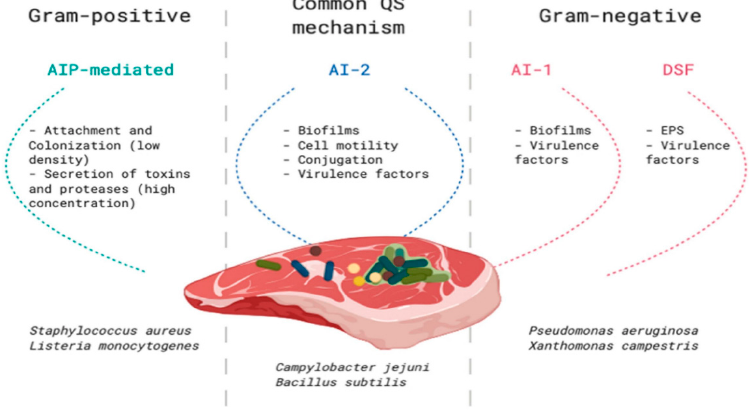
Figure 1. Schematic representation of the main QS mechanisms (from [8] with permission from Elsevier; license number: 5433491396764).